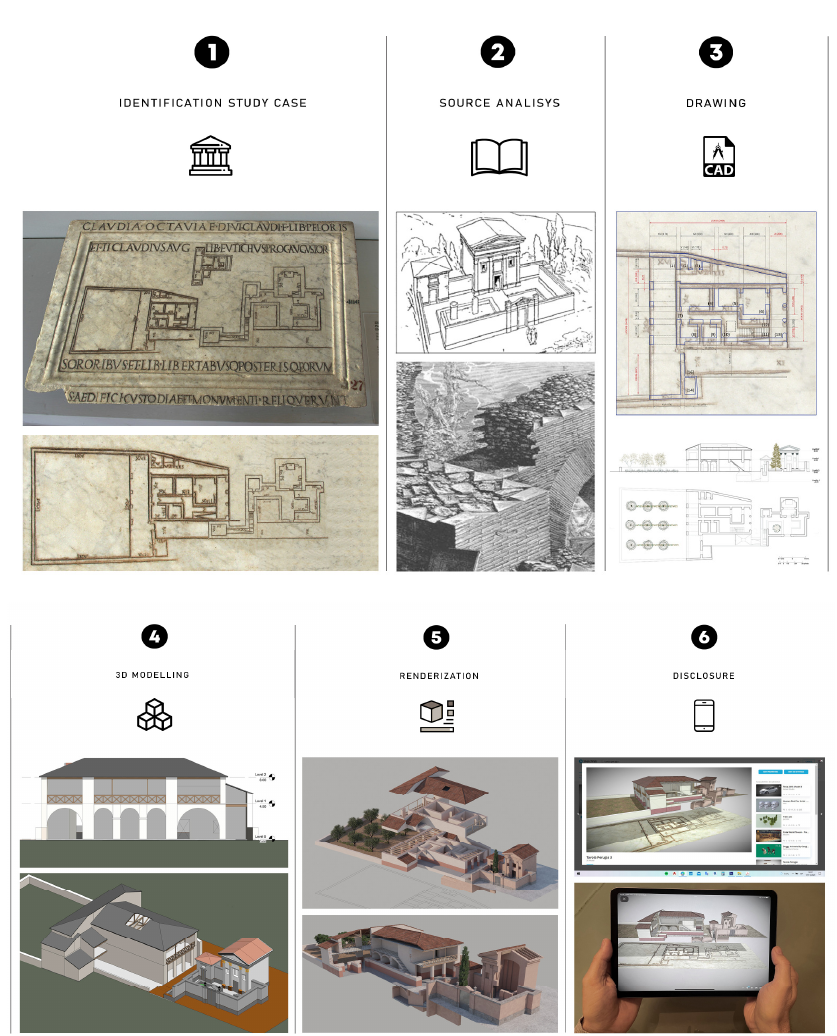
Figure 9. The process that, starting from the analysis of the artefact led to the sharing of the 3D final